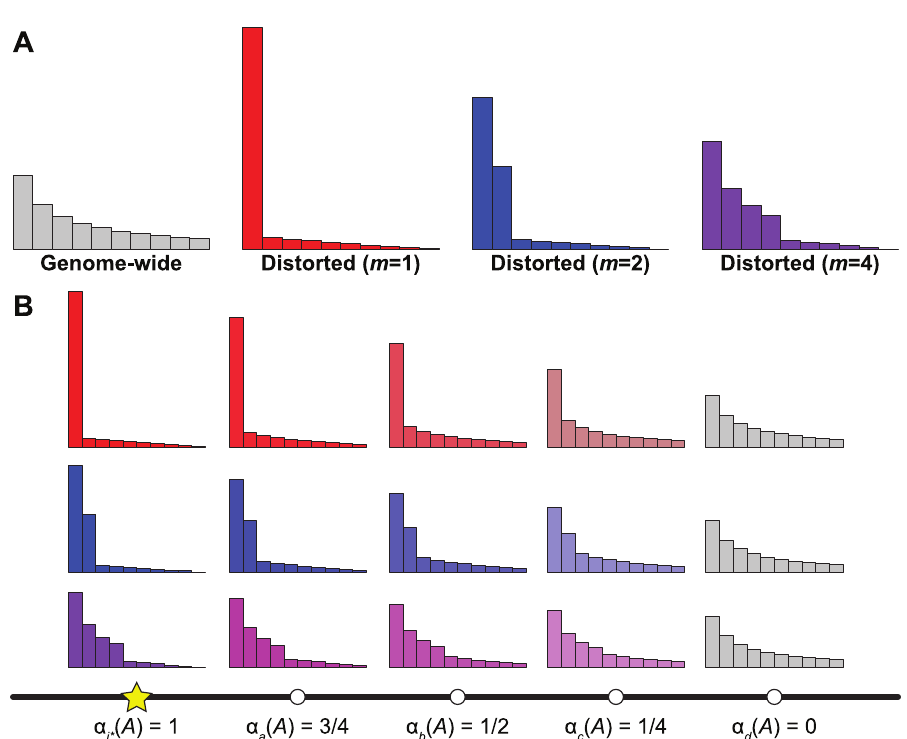
Fig 1. Schematic of the saltiLASSI mixture model framework. (A) Generation of distorted haplotype frequency spectra (HFS) for m = 1 (red), 2 (blue), and 4 (purple) sweeping haplotypes from a genome-wide (gray) neutral HFS under the LASSI framework of [13]. (B) Generation of spatially-distorted HFS under the saltiLASSI framework for a window i (white circles) with increasing distance from the sweep location (yellow star). When the window is on top of the sweep location, the HFS is identical to the distorted LASSI HFS, and α i ( A ) = 1. When a window is far from ( A ) = 0. For windows at the sweep location, the HFS is identical to the genome-wide (neutral) HFS, and α i ? intermediate distances from the sweep location, the HFS is a mixture of the distorted and genome-wide HFS, with the distorted HFS contributing α ( A ) and the genome-wide HFS contributing 1 − α ( A ). We show example spectra at i i windows a , b , c , and d that are of increasing distances from the sweep location i ? , with i ? < a < b < c < d .